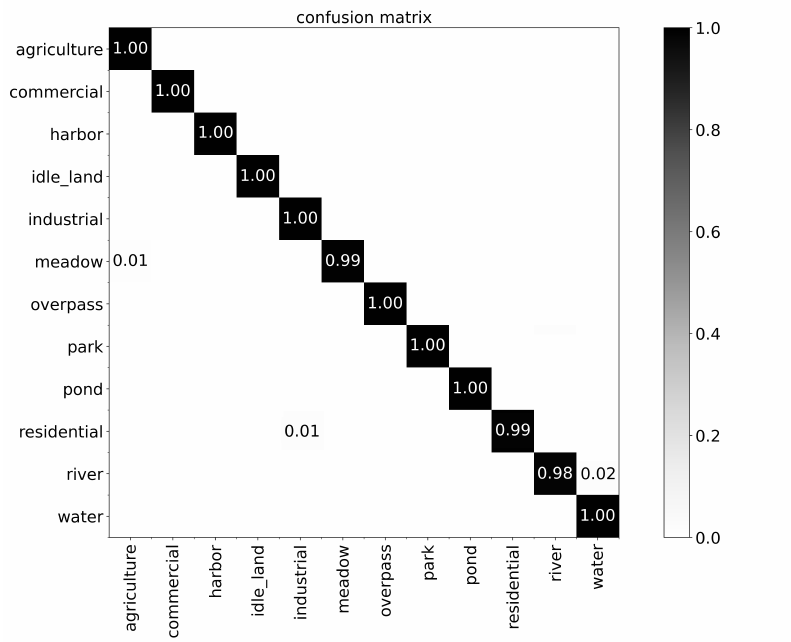
Figure 13. Confusion matrix of our model on SIRI-WHU dataset (train:test = 8:2).